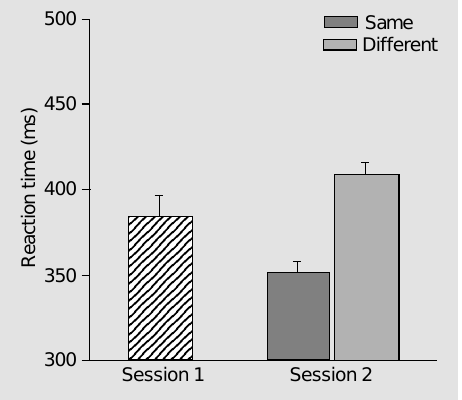
DifferentFigure 2. Mean reaction time (± SEM) of 12 participants to the vertical line inside the ring in the first testing session and at the same position as S1 or different ones in the second testing ses- sion of Experiment